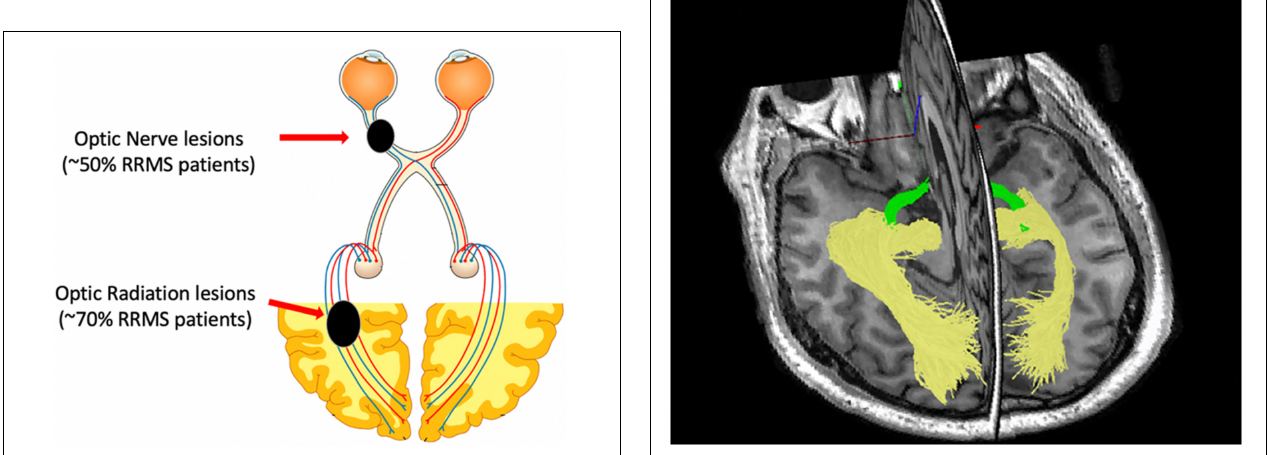
FIGURE 1 | Schematic representation of the visual system and sites of MS lesions.